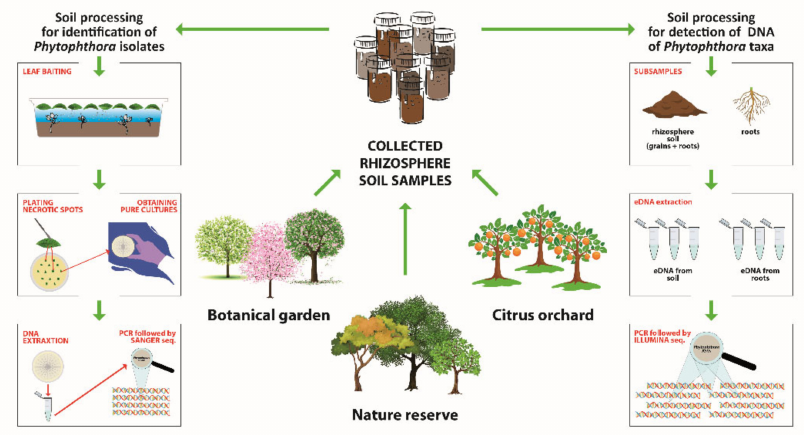
Figure 2. Experimental design of the